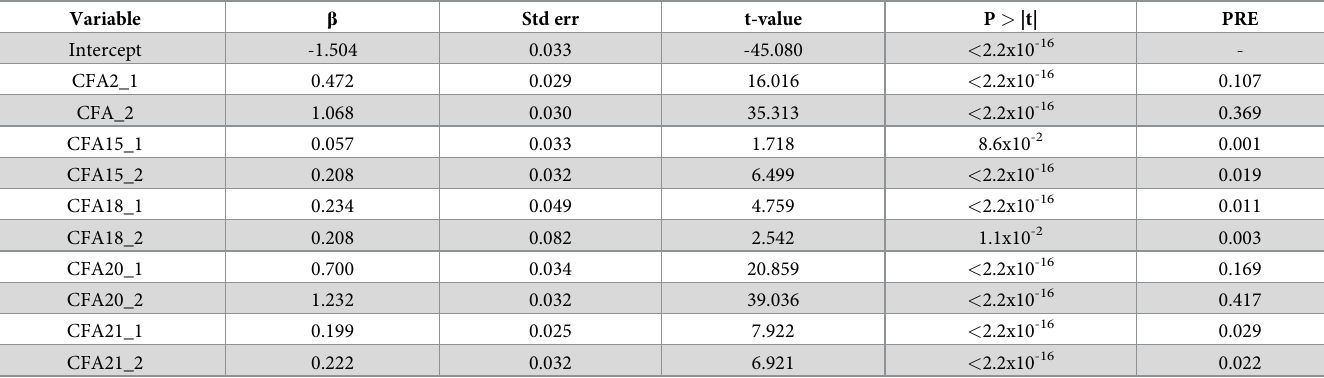
Coefficients, coefficient standard error, t score values, and t test p-values for the y-intercept and each of the independent variables in a predictive model that encodes each dog’s genotype at each of the five top GWAS markers according to whether or not it was heterozygous (“_1”), and whether or not it was homozygous for the red- associated allele (“_2”). For each of the independent variables, the proportional reduction of error (PRE) value is also shown. PREs represent the fraction of the total sum of squares error that is accounted for by each independent variable.